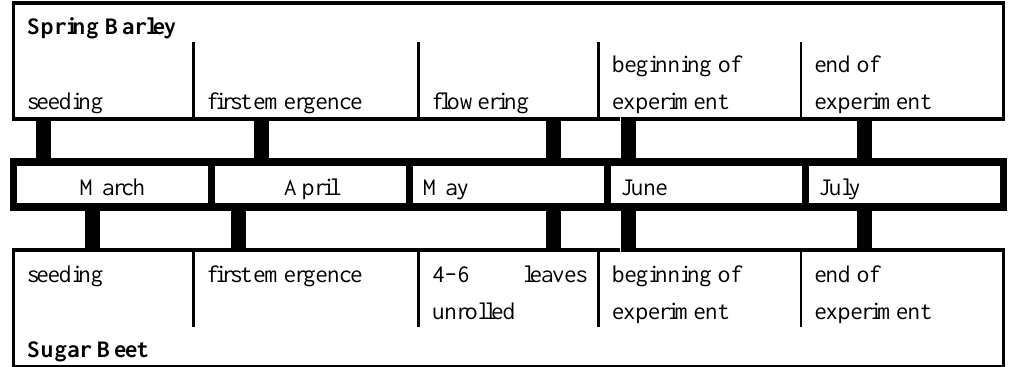
Table 2. Time schedule of the Bad Lauchstädt Experiment 2008. Black vertical pointers indicate in which part of the month particular events took